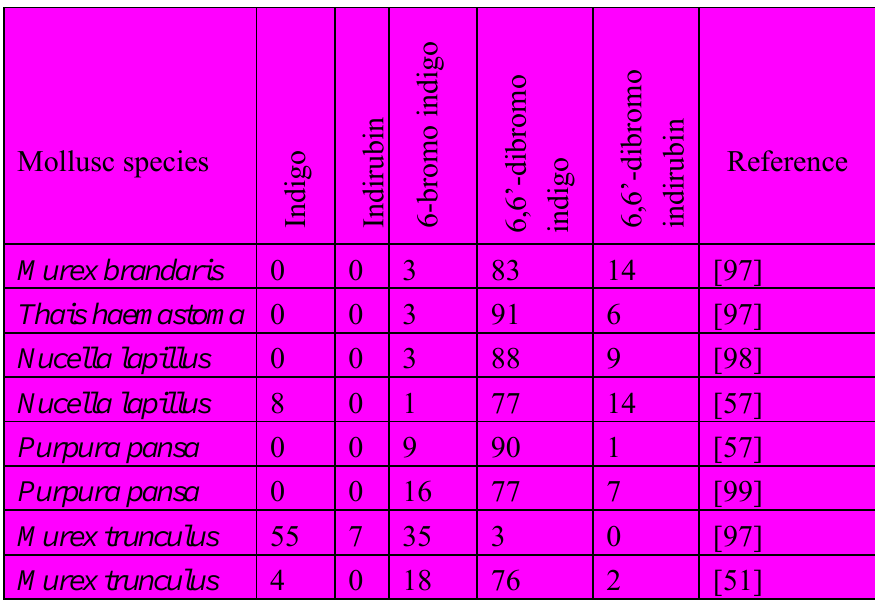
Table 3. The composition of the indigoid constituents of the purple dye from various